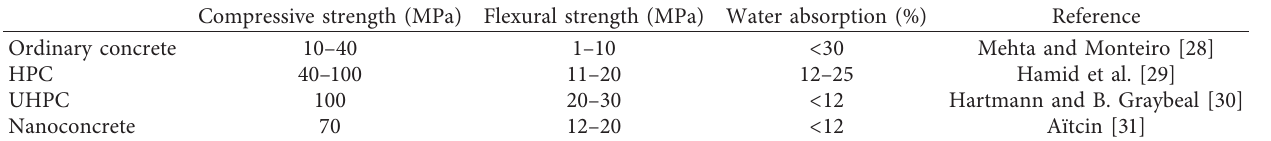
Figure 1: Relationship between the particle size and specific surface area of concrete materials Table 1: Summary of the performance of diverse kinds of concrete based on previous studies.